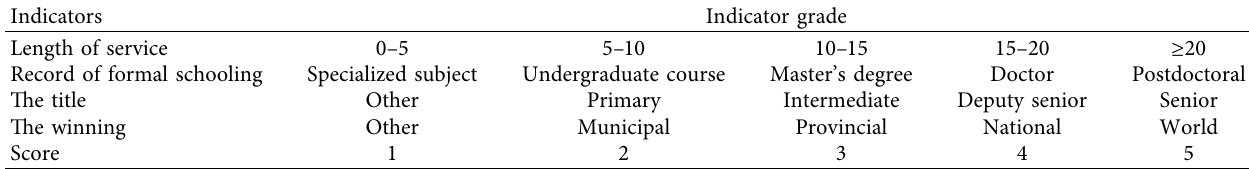
Table 2: Expert weight indicator table.